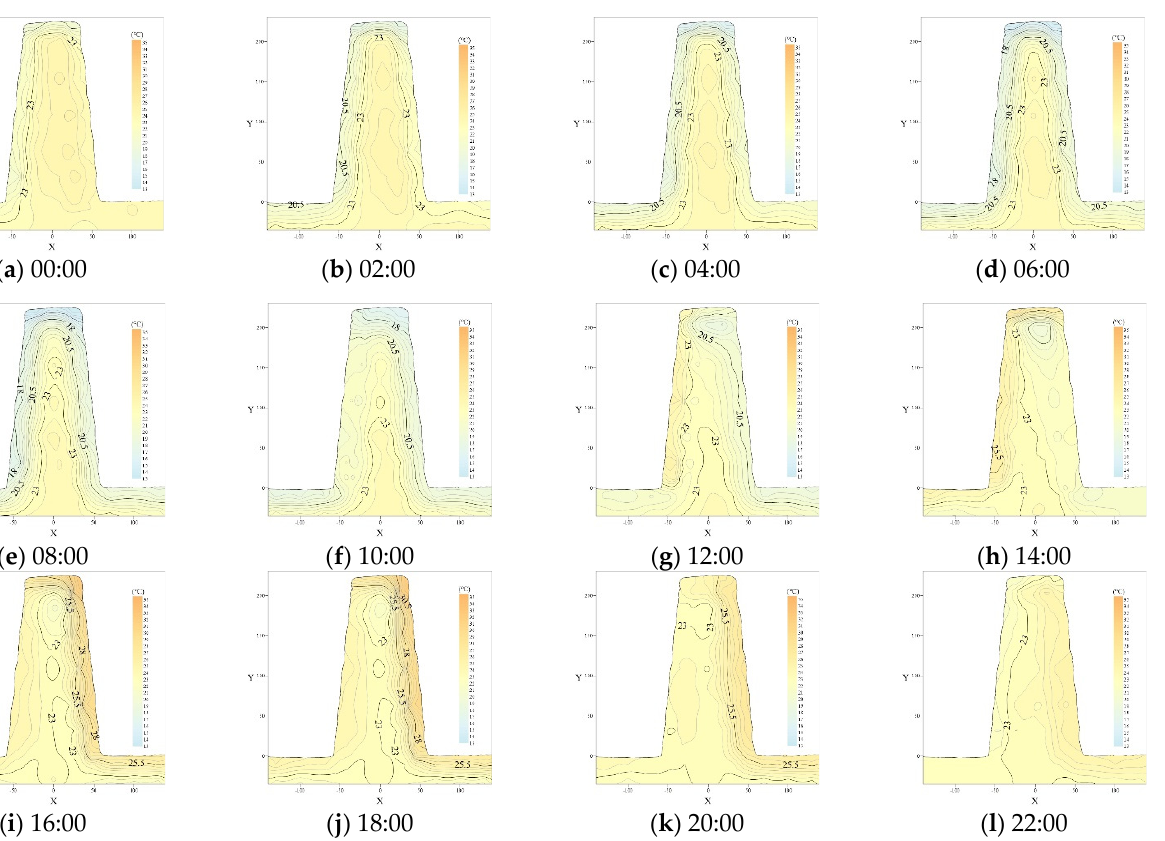
Figure 14. Temperature variations in the test wall on 22 September.